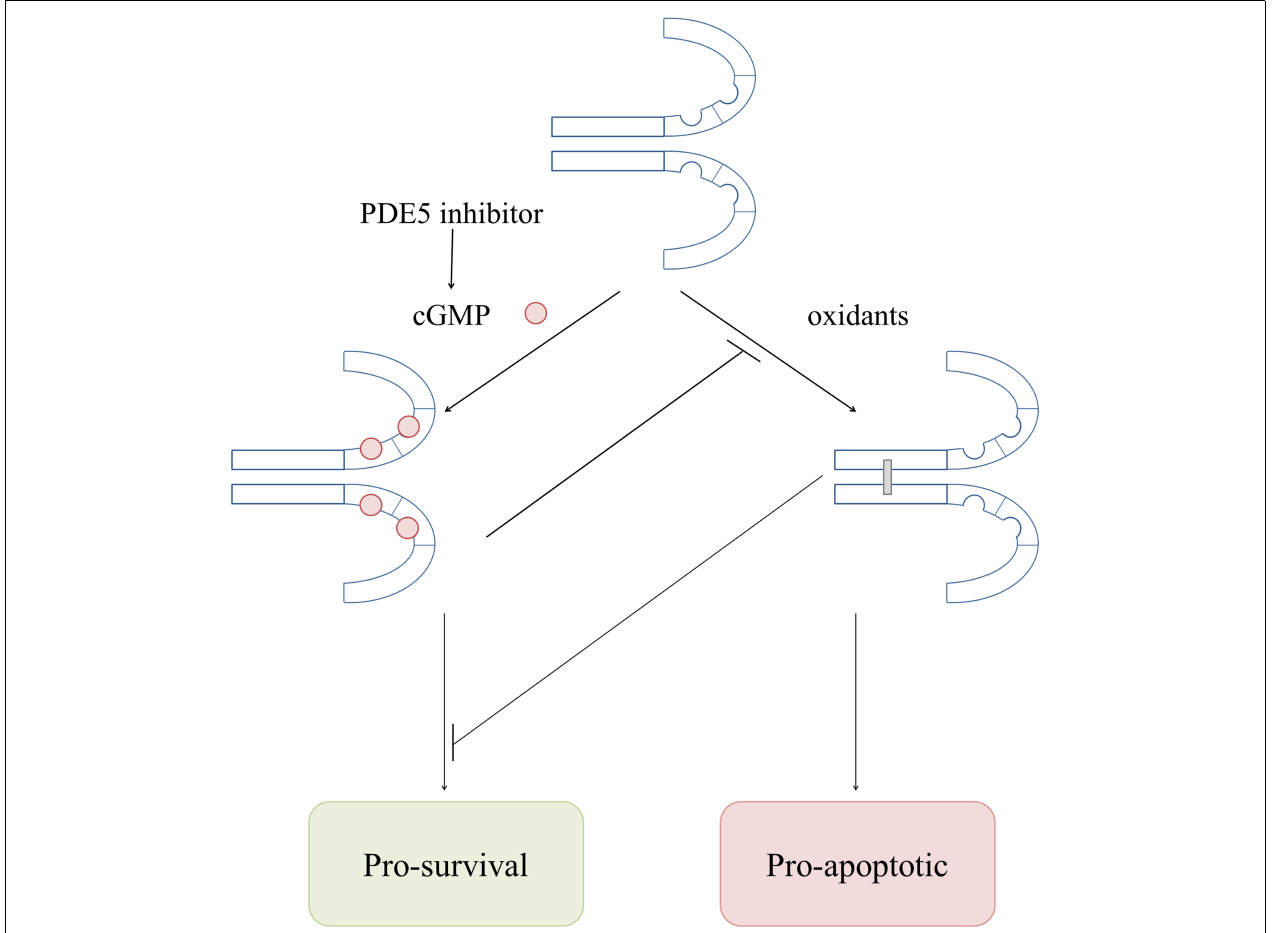
FIGURE 4 | Overview of the complex interaction between cGMP- and oxidant-induced PKG I a activation mechanisms in the